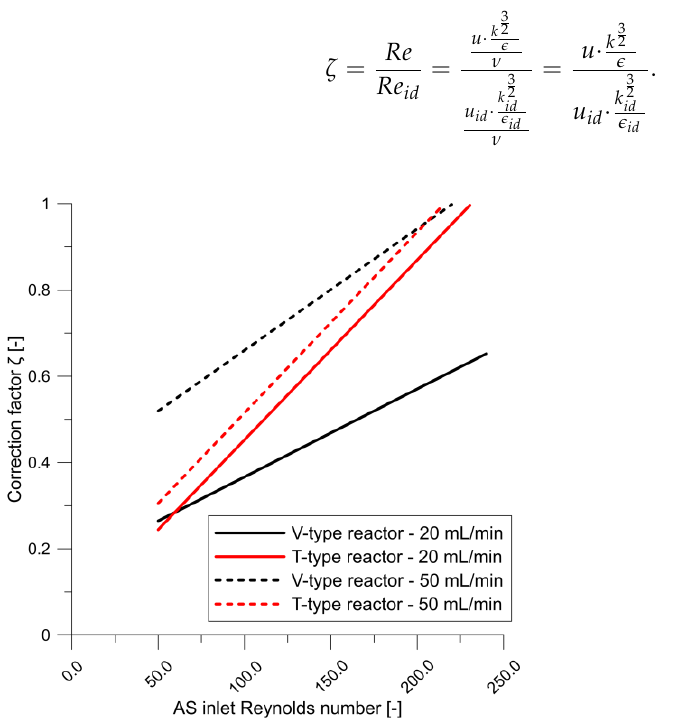
Figure 6. Correction factor (ζ) plotted as functions of AS inlet Reynolds number for different reactor types and flow rates.